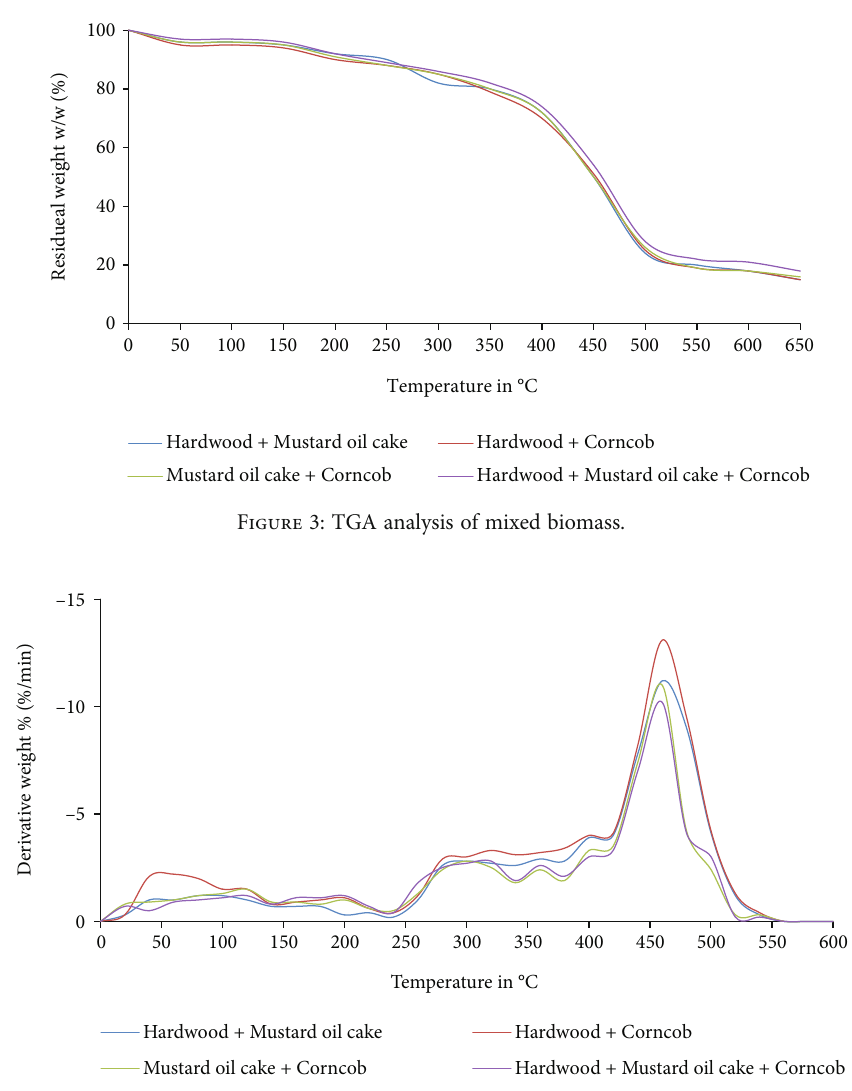
Figure 4: DTG analysis of mixed